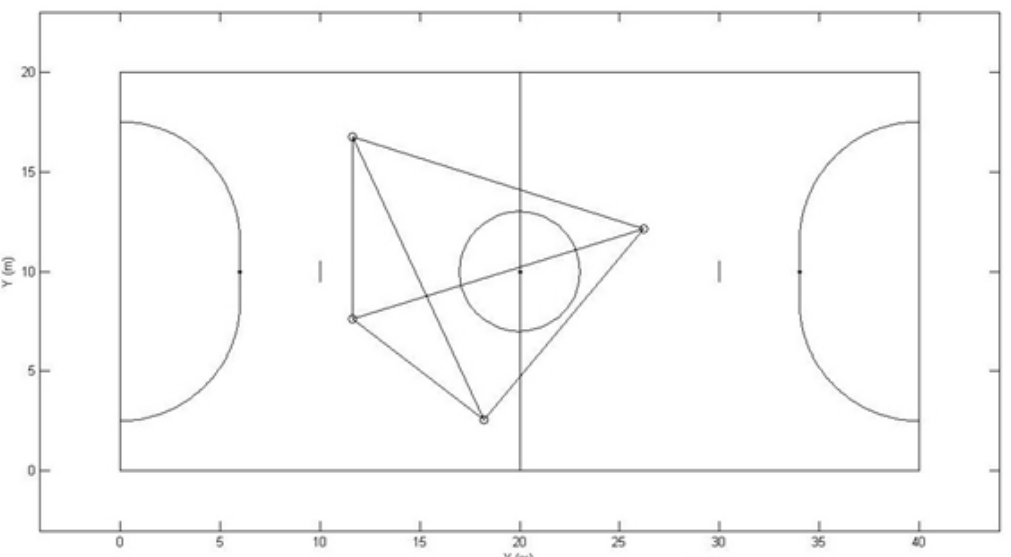
Figure 4. Example of one frame with the 2-D positions of the quartet of athletes on the court and the Euclidian distance of each athlete with respect to the all team his